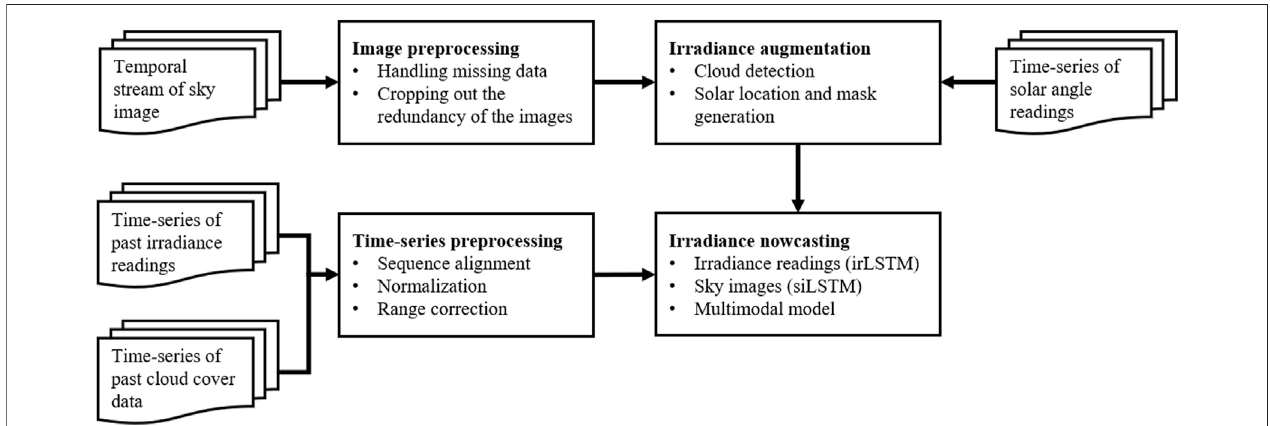
FIGURE 1 | The proposed approach for solar irradiance nowcasting.